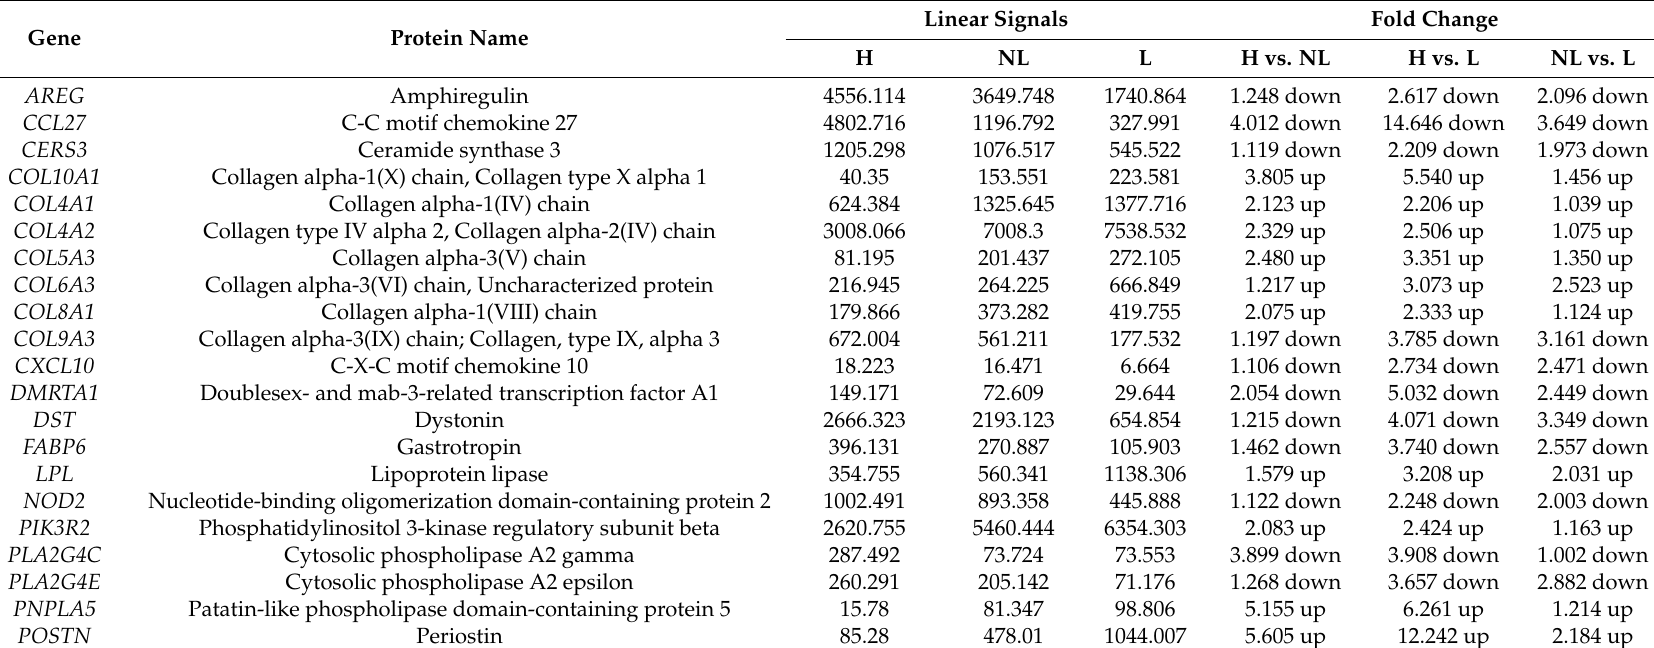
Table 3. Selection of genes whose expression is altered through the